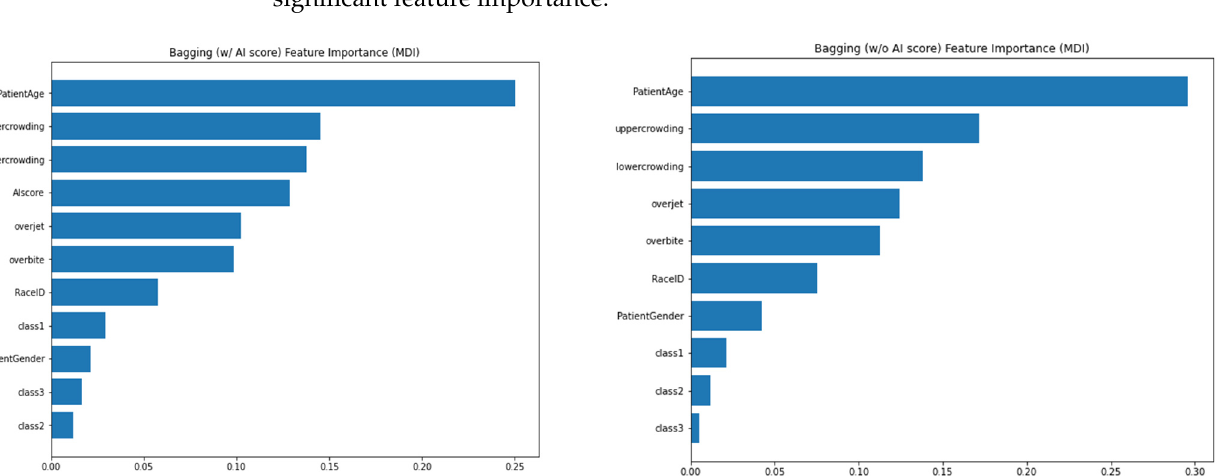
Figure 7. Permutation importance for the bagging model. With results very similar to the bagging model, the feature importance of the ada- boost model (with or without an AI score; Figure 8) shows that patient age, maxillary crowding, and mandibular crowding are the three most predictive components. Overjet, overbite, and race identification also have significant feature importance.